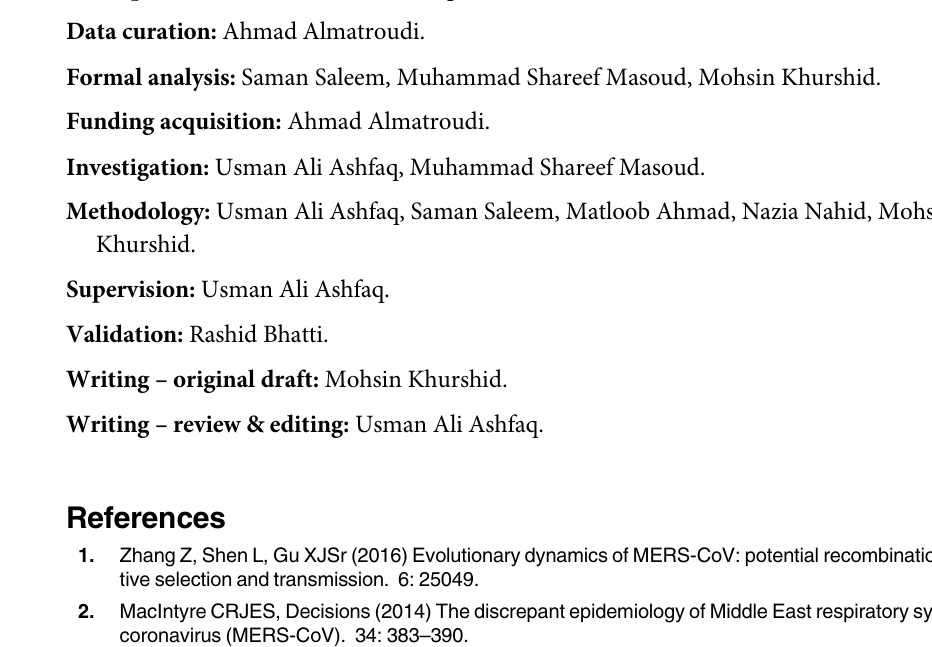
S1 Fig. Schematic illustration of secondary structure prediction of vaccine construct through